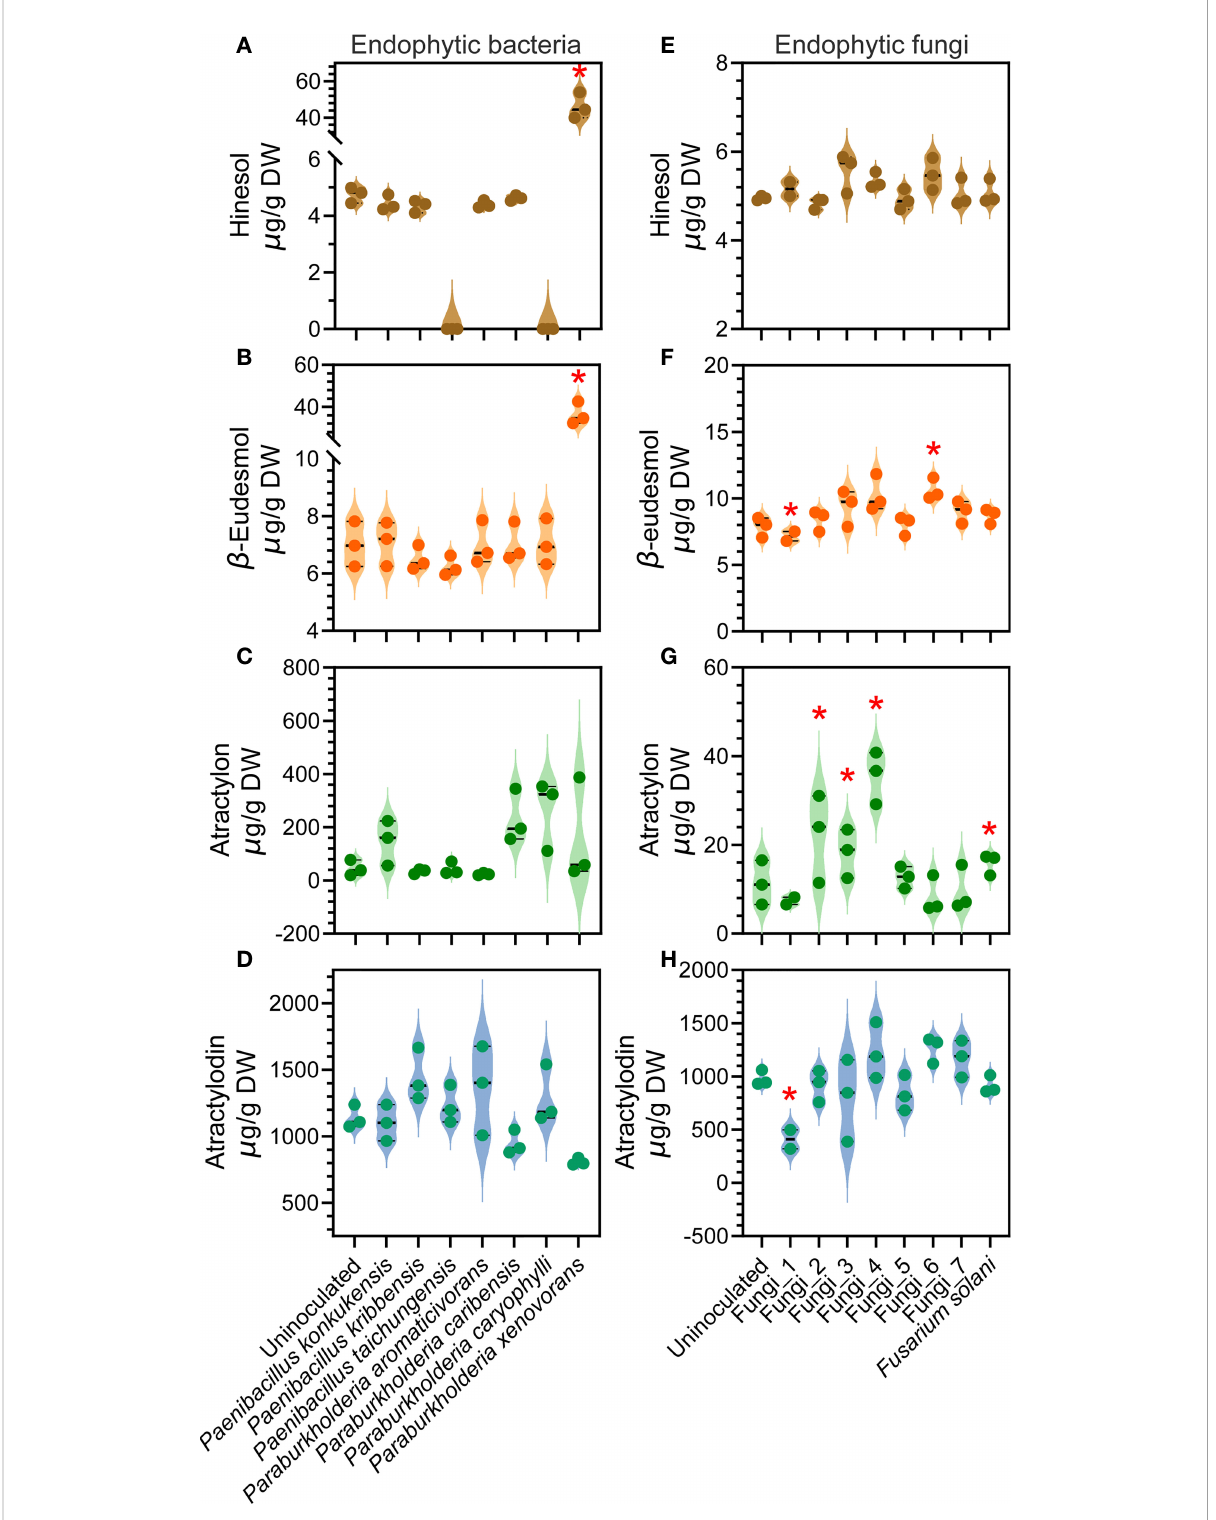
FIGURE 6 Effects of individual endophytic bacterial or fungal isolates on the concentration of four major medicinal compounds in A. lancea root veri fi ed via inoculation. (A – D) results of endophytic bacteria inoculation; (E – H) results of endophytic fungi inoculation. Asterisks represent signi fi cant difference compared with the uninoculated plantlets by Student ’ s t-test: * P <